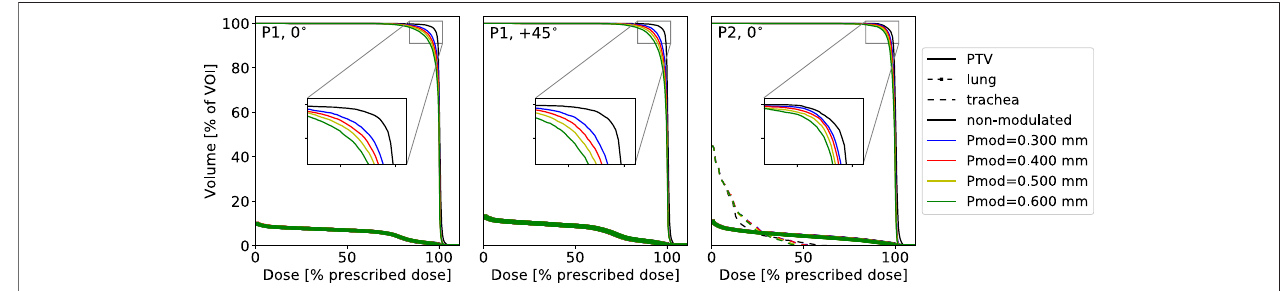
FIGURE 6 | DVHs of relevant VOIs for 12C plans on the non-modi fi ed CTs compared to plans on n (cid:1) 100 plans summed for n (cid:1) 100 modi fi ed CTs with different P mod values. Three treatment planning cases are shown with P1 planned with a horizontal fi eld as well as with one 45 ° to horizontal and with patient case P2 with a horizontal fi eld. Plans were optimized and calculated for physical dose with a 2 × 2 mm 2 raster scan size and a 3 mm depth step size.